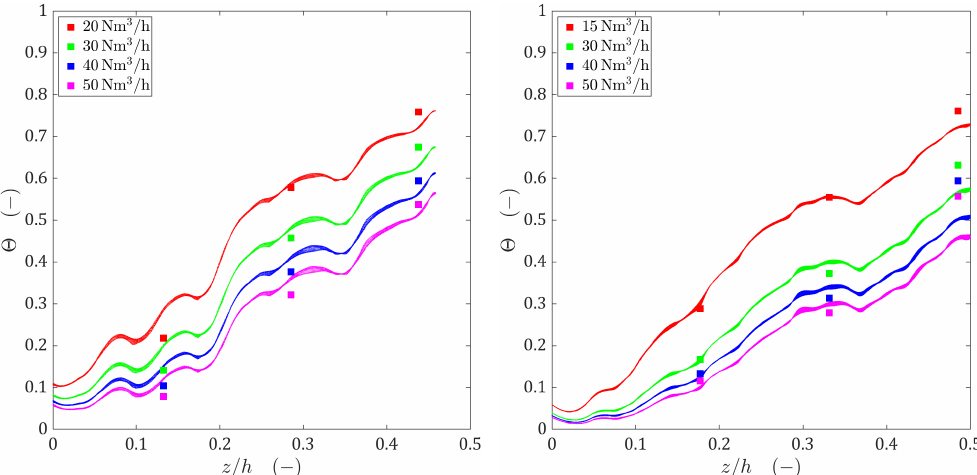
Figure 4. Axial profiles of dimensionless temperature at different flow rates for a 6-hole tablet ( left ) and a 10-hole cylinder ( right ). Comparison of CFD results (scattered cloud) against experimental data (big symbols).